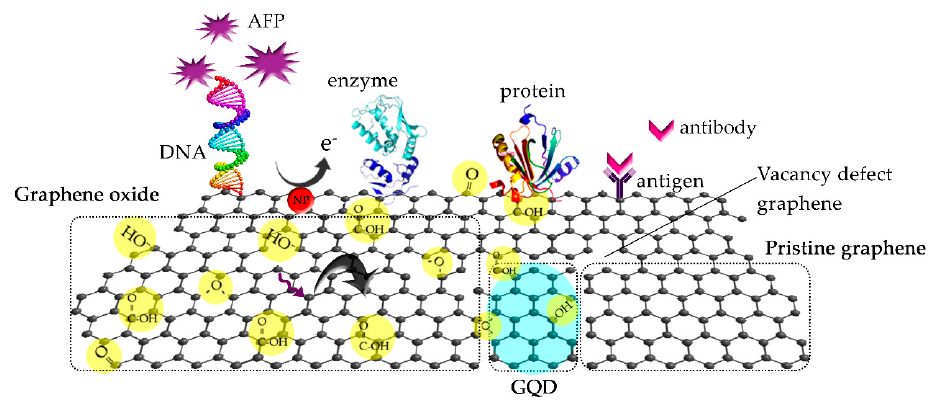
Figure 6. Schematic illustration of the graphene-based materials that can be immobilized with biomolecules as the receptor.